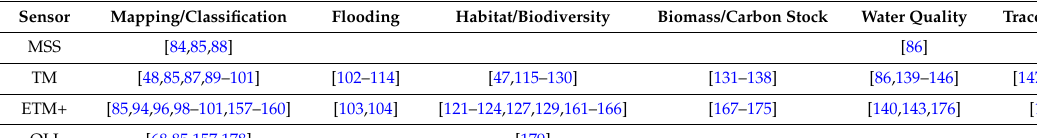
Table 2. Wetland studies using Landsat data for seven study themes.